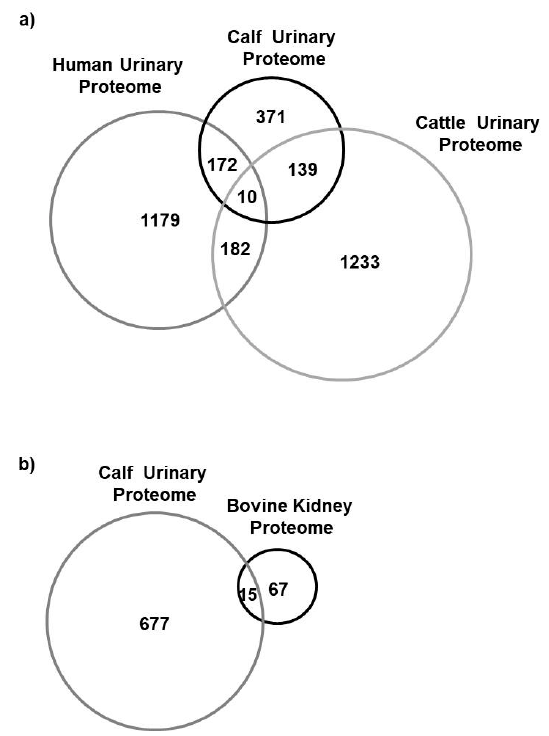
Figure 4. Comparison of human, bovine and calf urinary proteome ( a ) [5,34], comparison of calves’ urinary proteome with kidney proteome ( b ) [24].